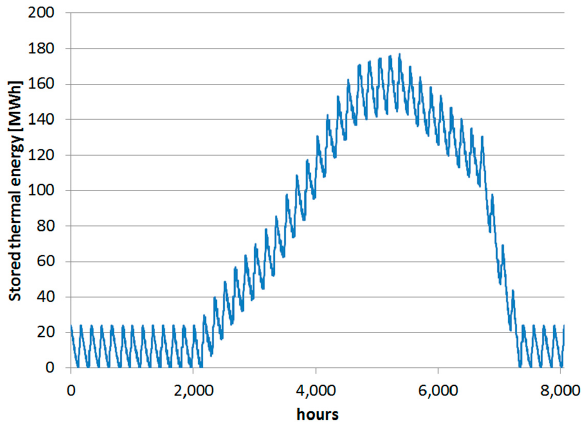
Figure 13. Yearly optimal operation of the storage − 70% environmental optimization of the distributed generation solution integrated with the central solar system.